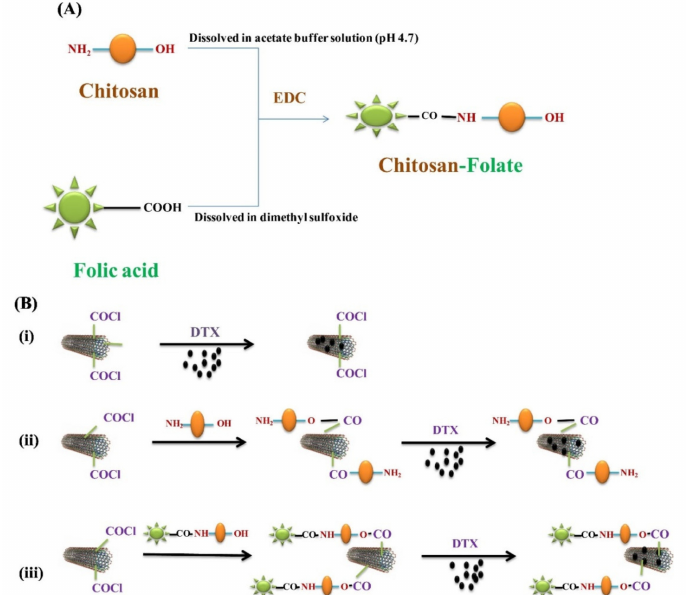
Figure 23. ( A ) Schematic diagram for synthesis of CS-folate (CS-FA) conjugate and ( B ) prepa- rations of ( i ) DTX-AcMWCNT (non-conjugated) ( ii ), DTX-CS/AcMWCNT (CS conjugated), and ( iii ) DTX-CS-FA/AcMWCNT (CS-FA conjugated) [144]. Reproduced with permission from Elsevier